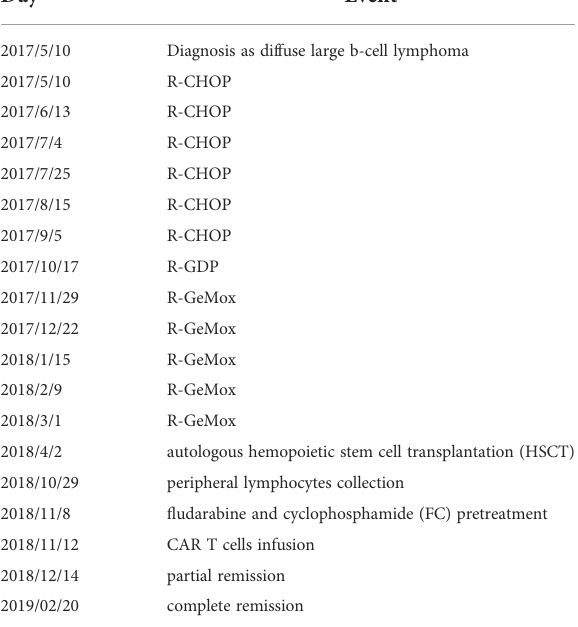
TABLE 3 Timeline of Patient